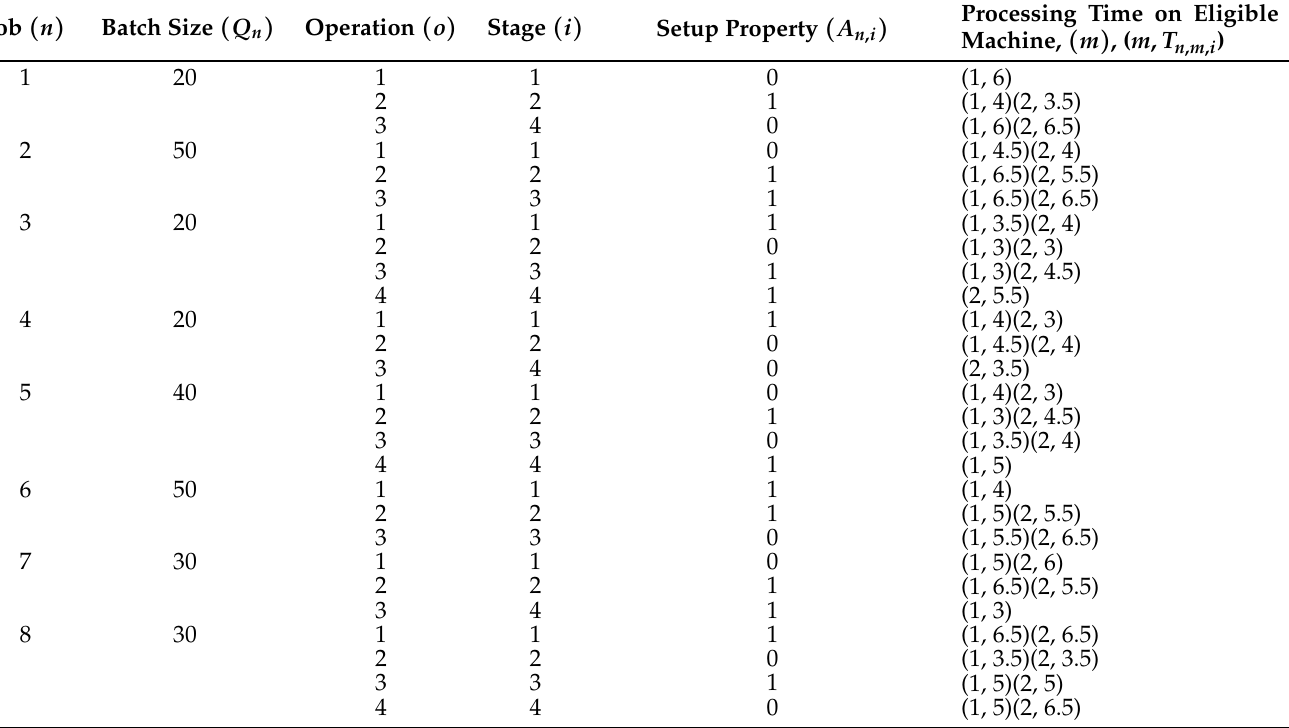
Table 4. The case study includes eight jobs with different batch sizes and processing times for each eligible machine.